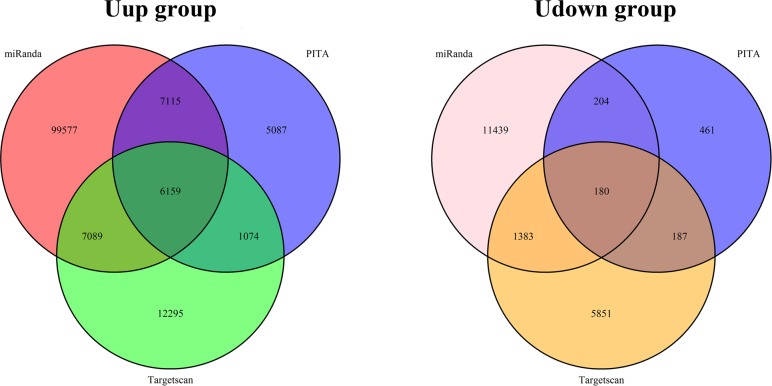
Targets of the differentially-expressed microRNAs.Venn diagrams of the targets of the microRNAs in the Uup and Udown groups. Target prediction was performed using Targetscan, Pita, and miRanda. The thresholds were scores ≥70 for Targetscan, ∆∆G ≤-5 for Pita, and seed = 7 for miRanda.